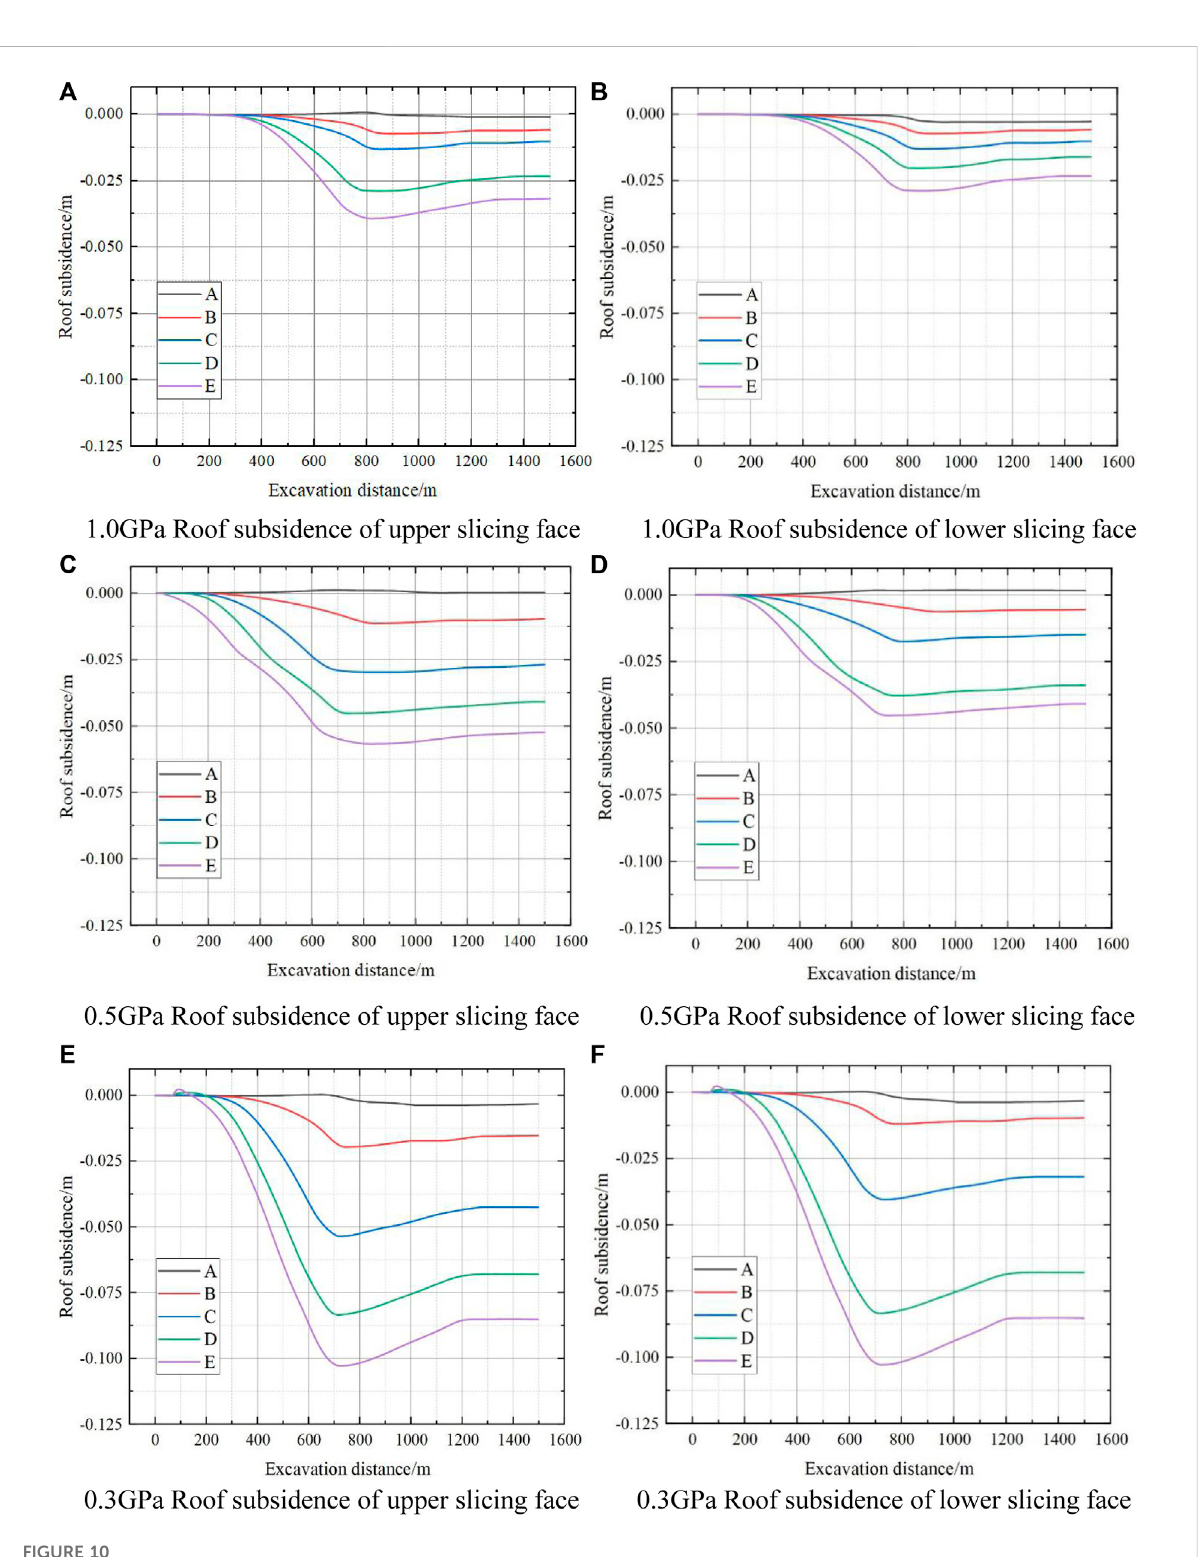
FIGURE 10 Diagram of the overburden movement process during slicing mining. (A) 1.0 GPa roof subsidence of the upper slicing face. (B) 1.0 GPa roof subsidence of the lower slicing face. (C) 0.5 GPa roof subsidence of the upper slicing face. (D) 0.5 GPa roof subsidence of the lower slicing face.